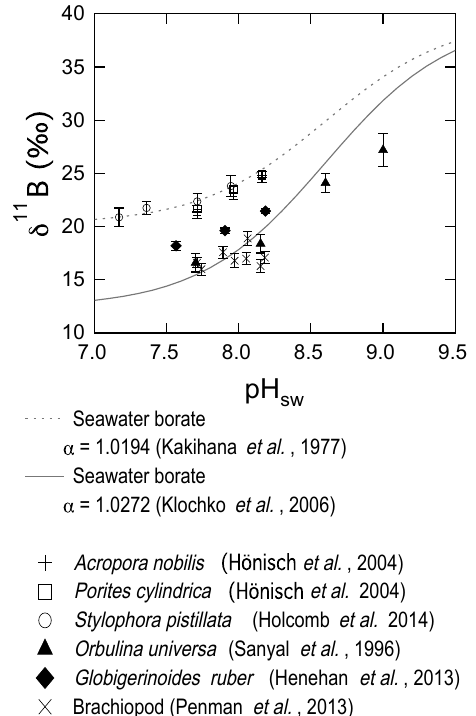
Figure 2. Examples of previously published δ 11 B CaCO trends for corals, foraminifera, and brachiopods. Although many B isotope data sets are available, only studies with ≥ 3 δ 11 B CaCO 3 –pH SW data spanning a sufficiently wide range of pH SW conditions were selected to illustrate the range of δ 11 B CaCO –pH SW trends published to date. The two grey lines cor- 3 respond to the theoretical seawater borate δ 11 B–pH curves that have been applied most frequently to interpret δ 11 B variability in marine calcifiers and were generated using a pK B of 8.6 at 25 ◦ C and 35psu (Dickson,